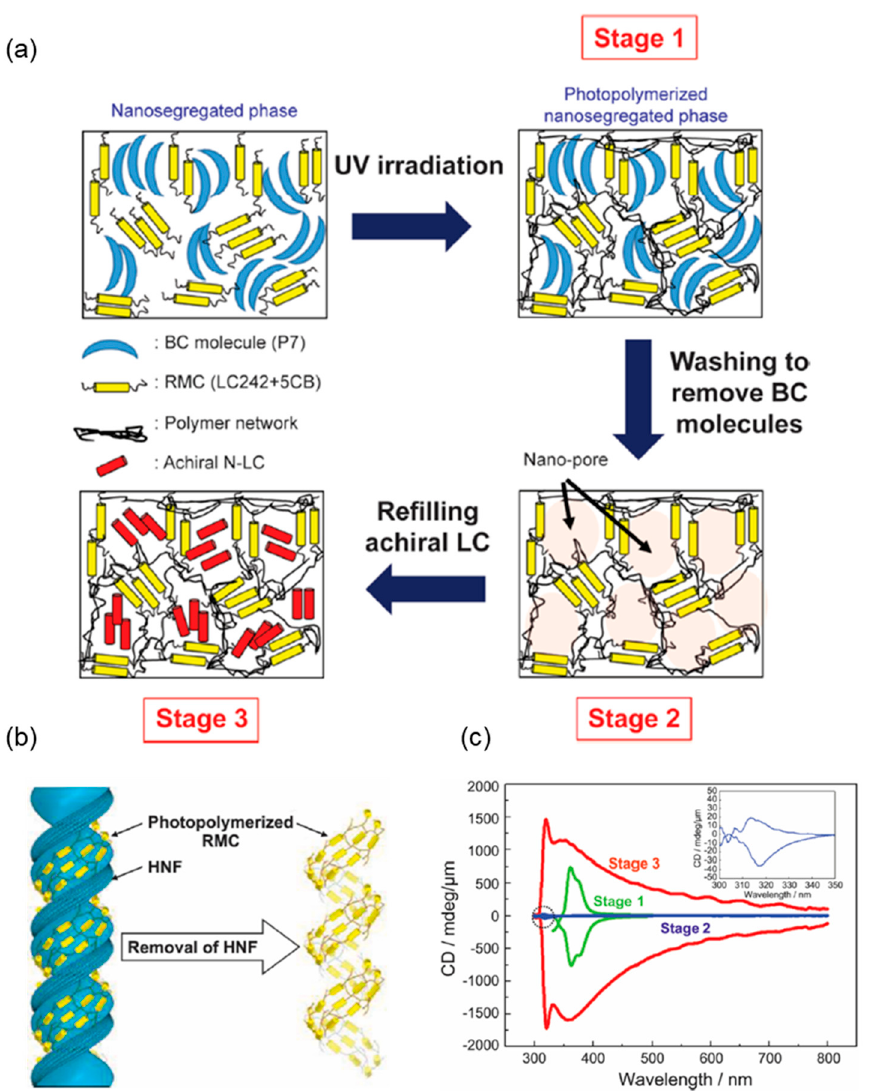
Figure 13. ( a ) Schematic illustration of the fabricating process for a chiral polymeric network replicated from the HNF. The BC molecule and RMC are mixed to form the HNF phase. UV irradiation caused photopolymerization and made the polymeric network formed on the HNF’s surface (Stage 1). BC molecules are selectively washed out from the composite, leaving pure polymer (Stage 2). Achiral rod-shaped molecules are injected into the chiral polymer template, and the chirality is transferred to them from the polymer (Stage 3). ( b ) Schematic image of the polymeric network before (Stage 2) and after (Stage 3) removal of HNF. ( c ) CD spectra for each stage with opposite chiral domains. The inset graph shows enlarged image of the spectrum in the wavelength range of 300 to 350 nm in Stage 2. Reprinted with permission from [90], Copyright 2020, American Chemical Society.